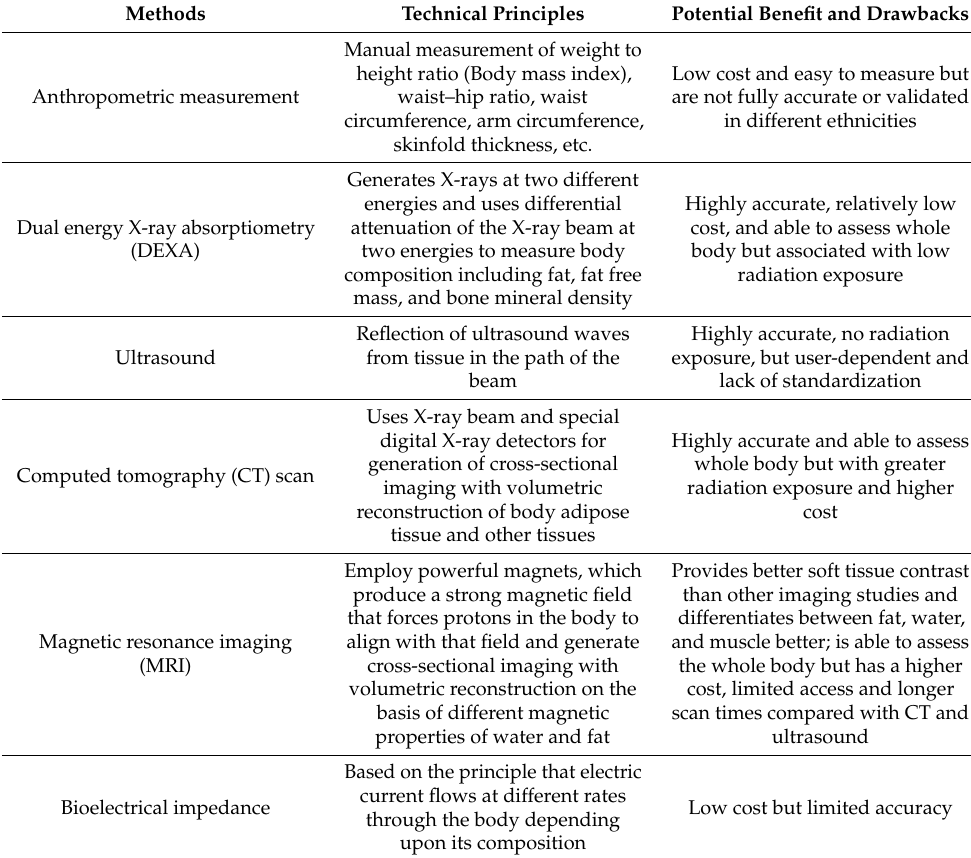
Table 1. Methods for the estimation of body fat composition and its